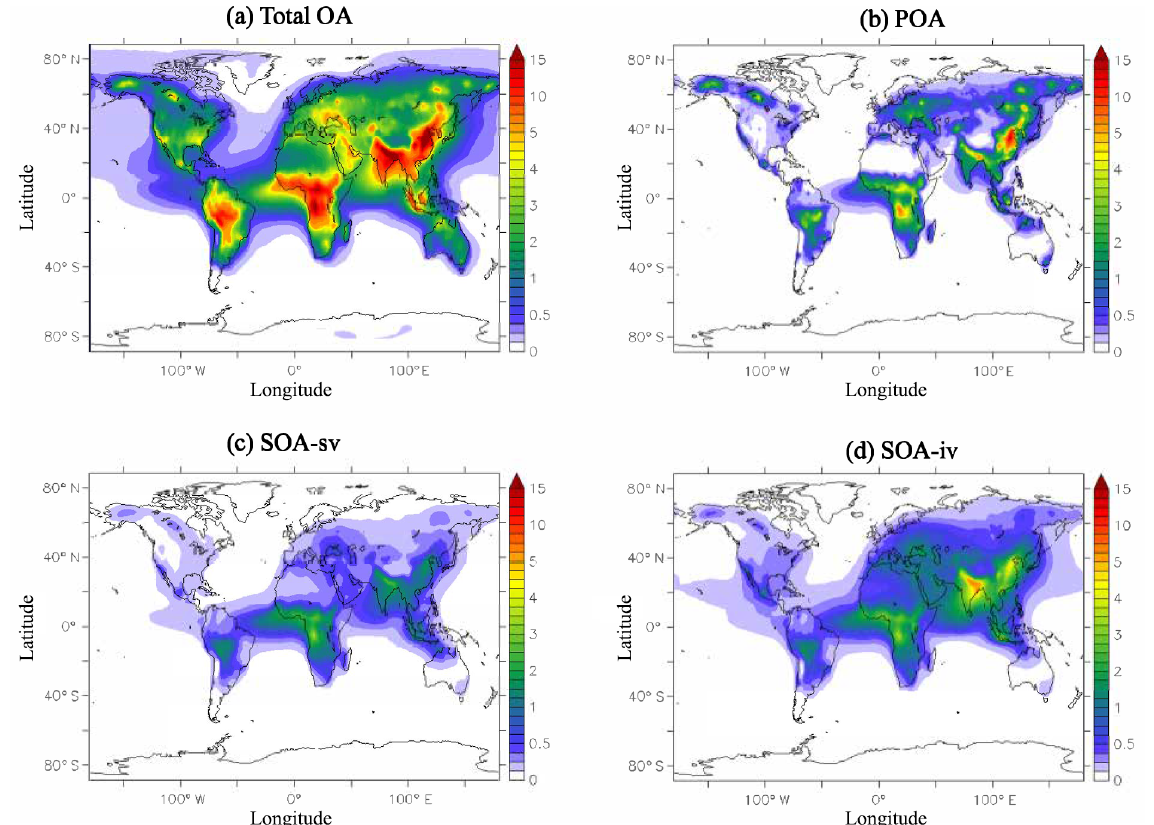
Figure 3. Predicted average surface concentrations (inµgm − 3 ) of (a) total OA (sum of POA, SOA-sv, SOA-iv, and SOA-v), (b) POA and (c) SOA from the oxidation of SVOCs (SOA-sv), and (d) SOA from the oxidation of IVOCs (SOA-iv) for the reference simulation during the 2001–2010